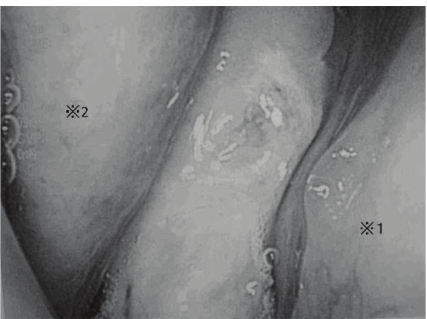
Figure 1: Endoscopic findings of intranasal lesion n 1: Septum n 2: Middle turbinate.